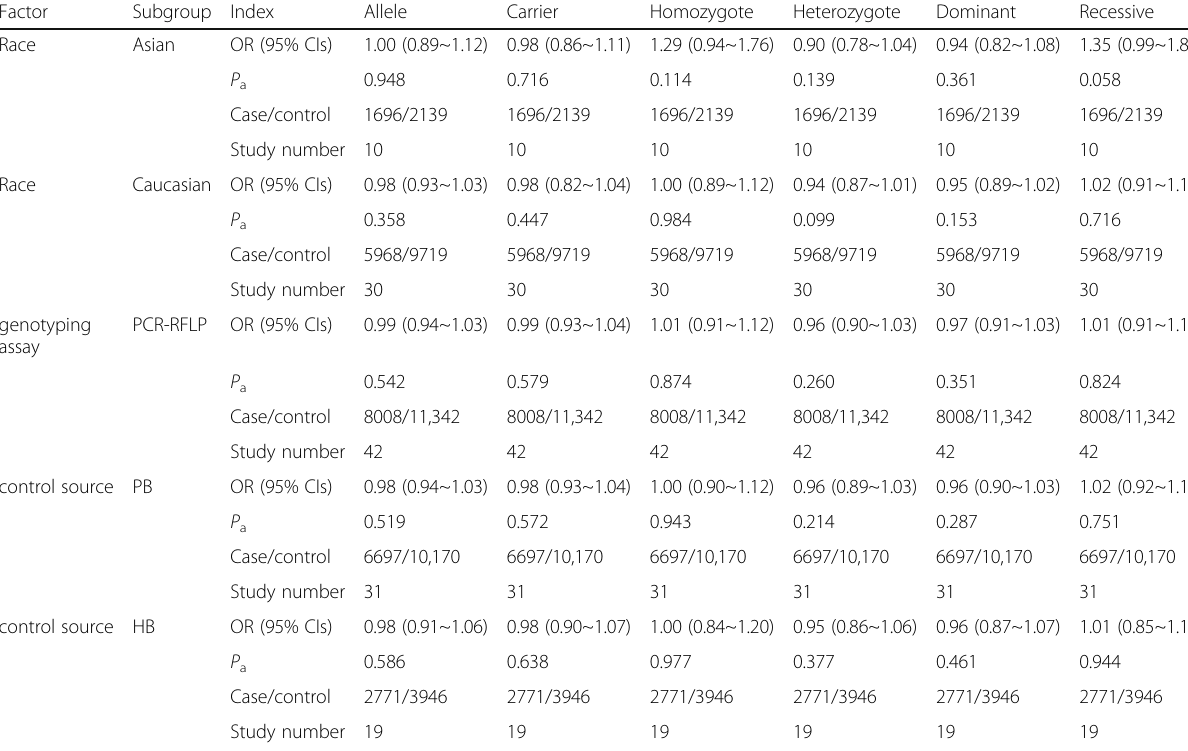
Table 3 Subgroup analysis of the GSTP1 rs1695 A/G polymorphism by race, genotyping assay and control source Factor